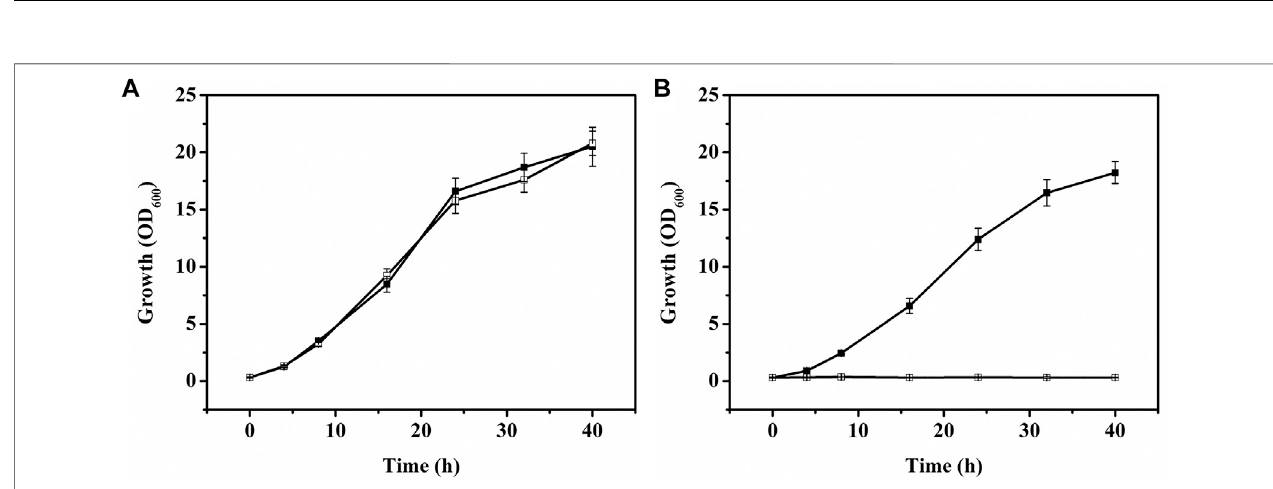
FIGURE5| Transcriptionallevelsof gfp in C.glutamicum strainsduringthecultivationprocess. (A) Transcriptionallevelsof gfp in C.glutamicum /pMI-4- gfp andthe myo-inositol concentrations during the cultivation process. (B) Transcriptional levels of gfp in C. glutamicum Δ iolG Δ oxiC Δ oxiD Δ oxiE /pMI-4- gfp and the myo-inositol concentrations during the cultivation process.